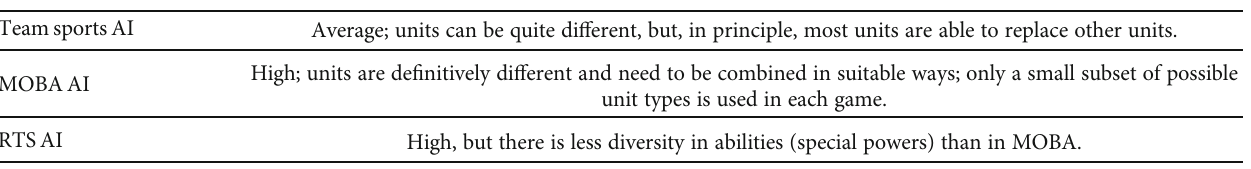
Table 3: Agent role property. Does the game impose speci fi c roles the agents have to ful fi ll? Team sportsAI MOBA